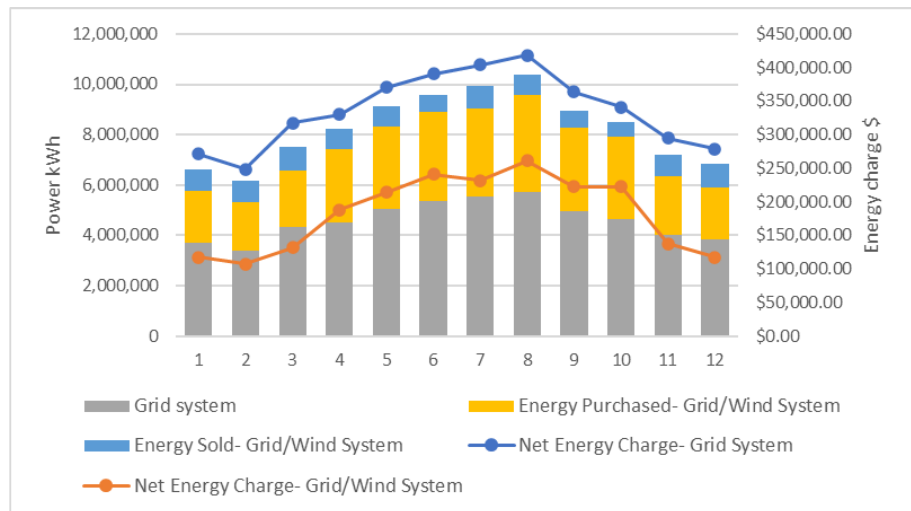
Figure 11. Discounted cash flow Vs nominal cash flow.